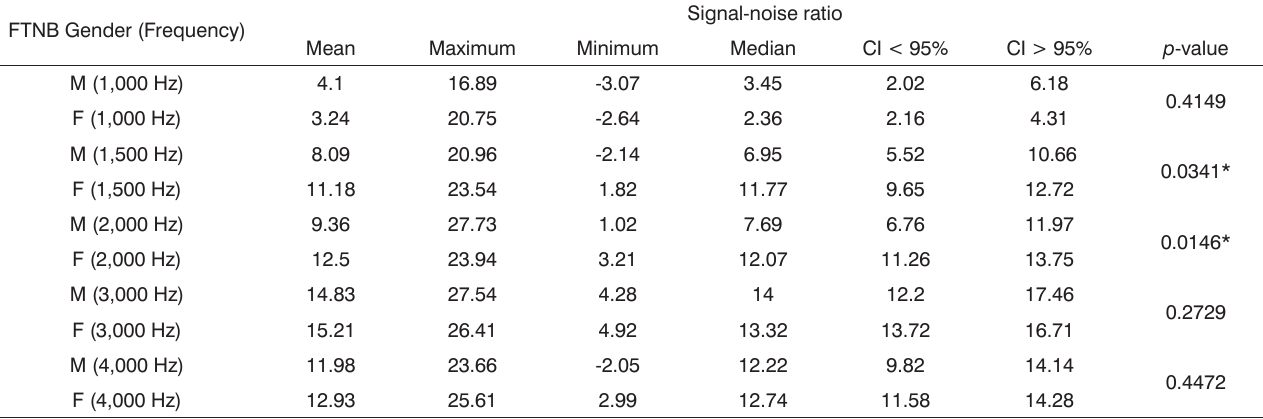
Table 4. Description of the signal-noise ratio variable of TEOAEs (in dB SPL), for full term newborns according to gender in the 1,000 to 4,000Hz frequency bands.